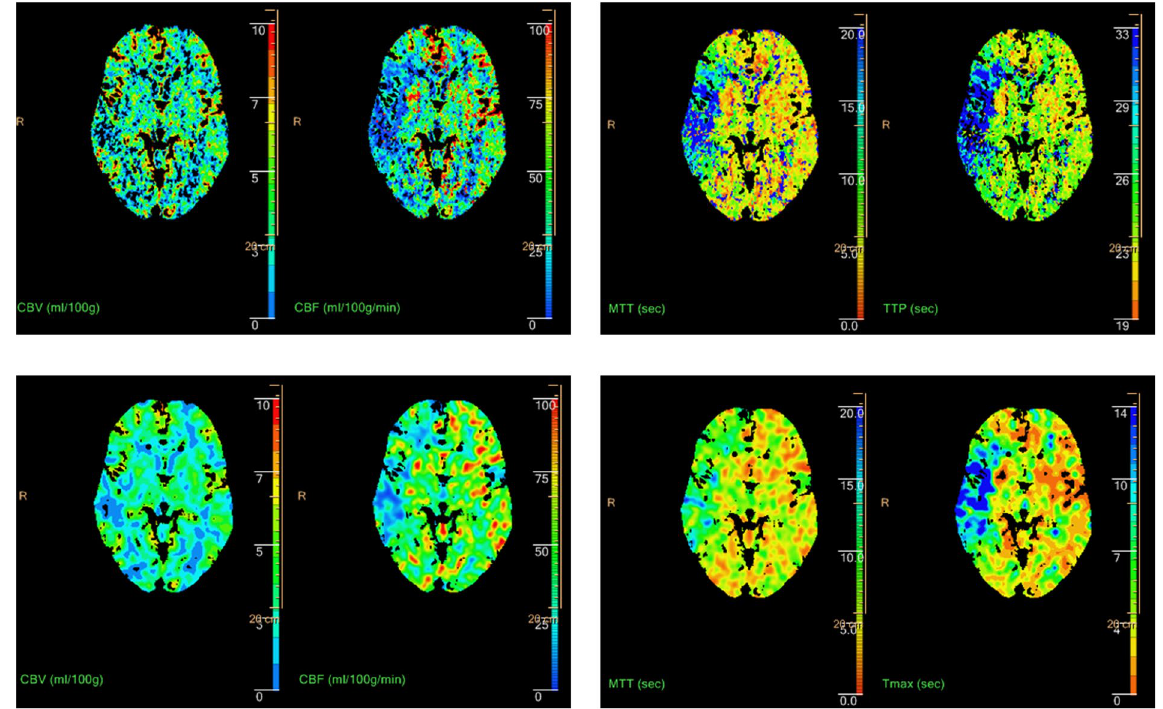
Figure 1. ATS (upper row) - and ATI (lower row) - maps of a patient with a partial but significant CTP- mismatch due to M1-occlusion of the right MCA. CBV = cerebral blood volume. CBF = cerebral blood flow. MTT = mean transit time. TTP = time to peak. Tmax = time to the maximum of the residue function obtained by deconvolution.